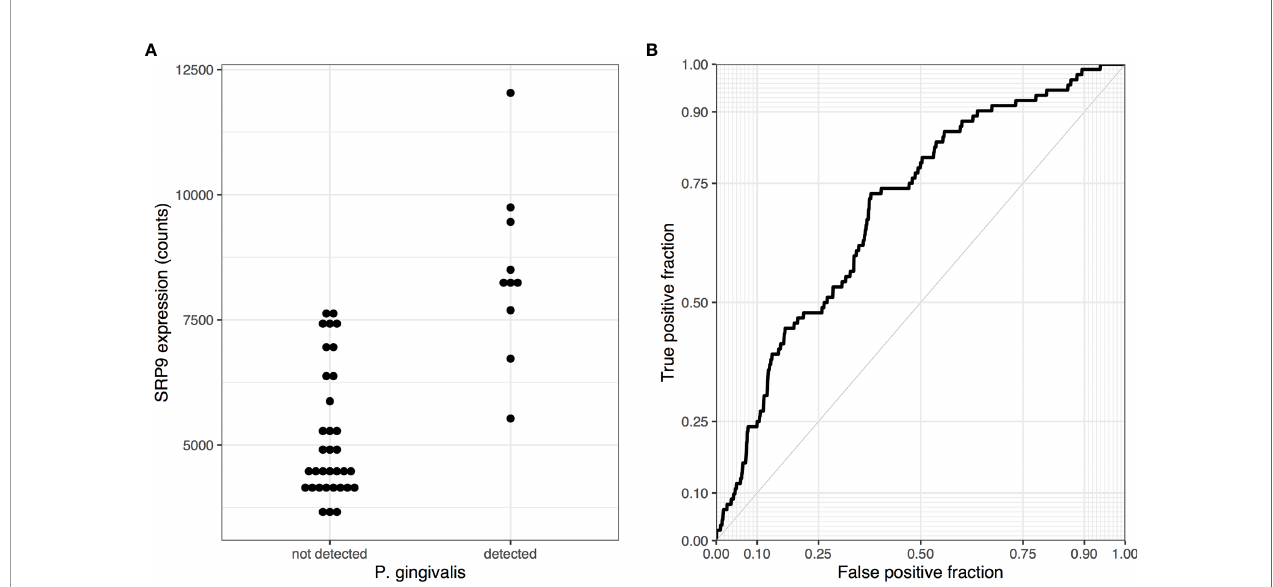
FIGURE 2 | Visualization of differential expression results. (A) Dotplot of SRP9 expression is plotted for samples with and without P. gingivalis reads. (B) ROC for the ER translocation genes when all genes are ranked according to direction and signi fi cance [signed log(p-value)].